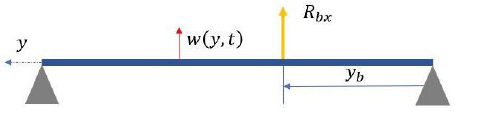
Figure 4. Model of the